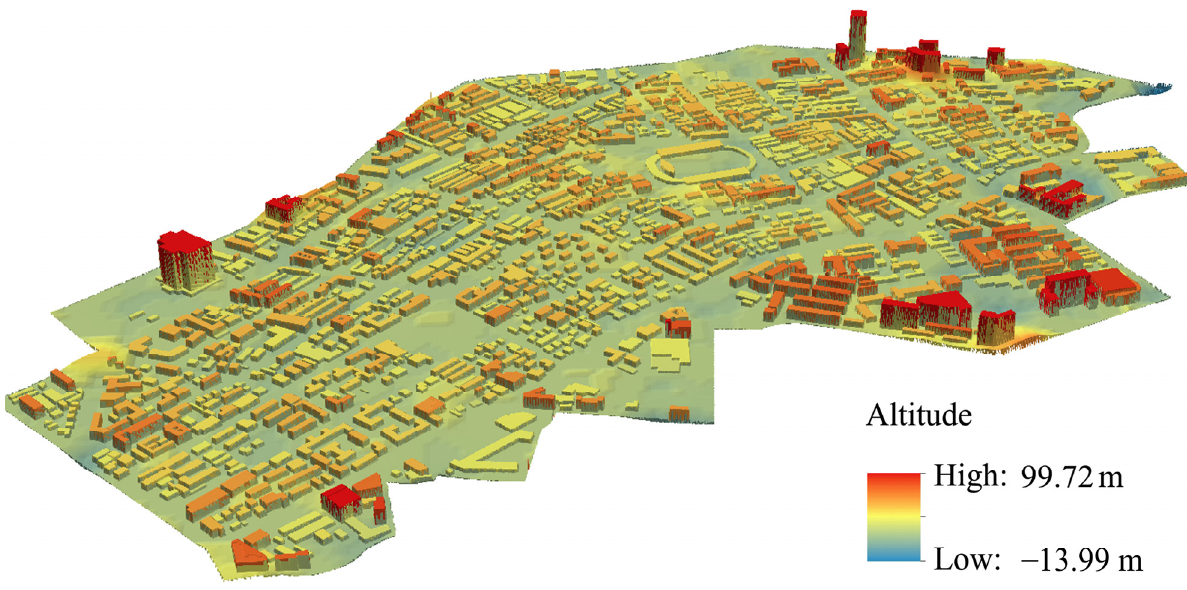
Figure 2. The urban digital elevation model (UDEM) of the study area